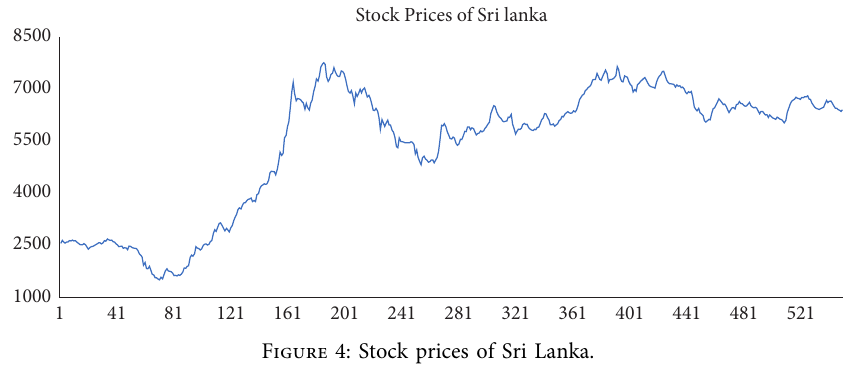
Figure 4: Stock prices of Sri Lanka.